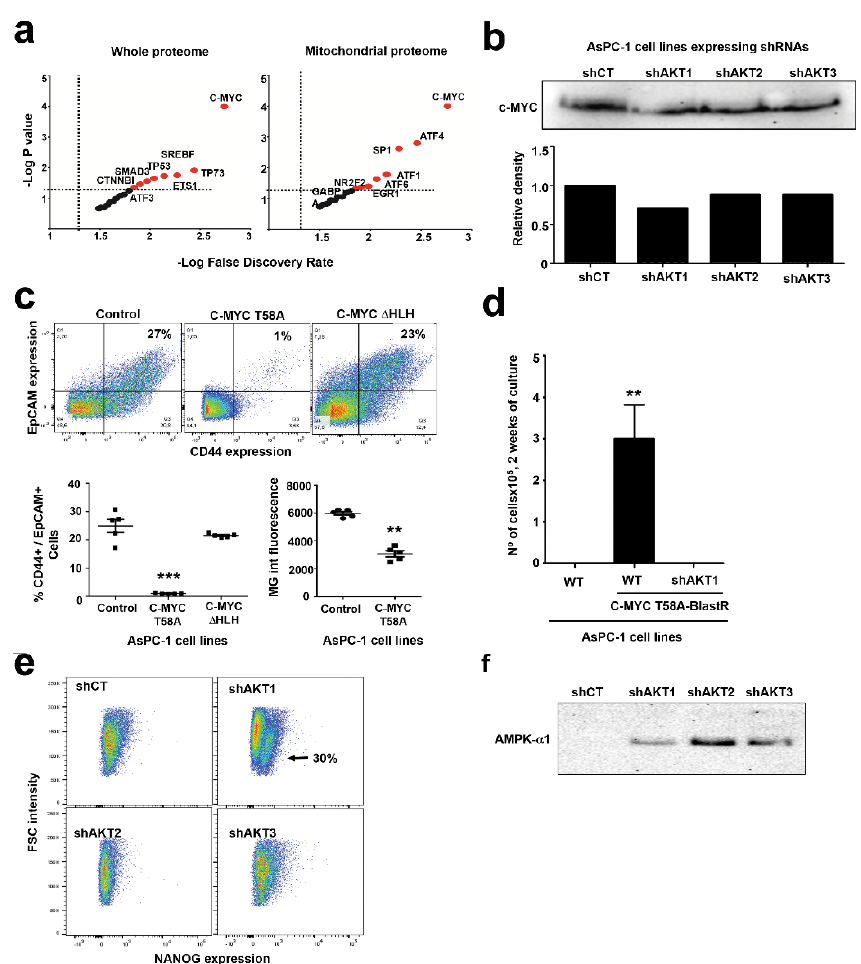
Figure 7 . Adaptation to AKT1 silencing uncovers specific regulation of C-MYC, NANOG and AMPK. ( a ) Dot plots of transcription factors (indicated within the graph) associated to potential regulation of the proteomes associated to silencing of AKT isoforms compared to shCT-control cancer cells. The left graph represents data from the whole differential proteomes, while the right graph represents data from the mitochondrial differential proteomes. Horizontal and vertical dotted lines separate statistically significant P values and false discovery rates for each identified transcription factor. In red, transcription factors with significant association to the differential proteomes. ( b ) The Western blot on top shows C-MYC expression in the indicated AsPC-1 cell lines. The bar graph indicates the band intensity from the Western blot above. ( c ) The flow cytometry density plots show CD44/EpCAM expression in the indicated cell lines. Percentages within the graphs show the percentage of CD44-EpCAM double positive AsPC-1 cells. The scatter plot represents the same data from five independent experiments. Statistical comparisons were performed by ANOVA and pairwise Tukey´s tests. ( d ) Bar graph representing means and standard deviations of the number of the indicated cell lines transduced with the lentivector expressing active C-MYC and blasticidin resistance, after two weeks of selection. Statistical comparisons were performed by one-way ANOVA. ( e ) NANOG expression assessed by flow cytometry in the indicated cells lines. A well-defined NANO-positive population is indicated with an arrow. ( f ) AMPK expression by Western blot in the indicated cell lines. *, **, ***, indicate significant ( p < 0.05), very significant ( p < 0.01) and highly significant ( p < 0.001) differences, respectively. Original uncropped Western blots and densitometry readings are shown in Figure S11